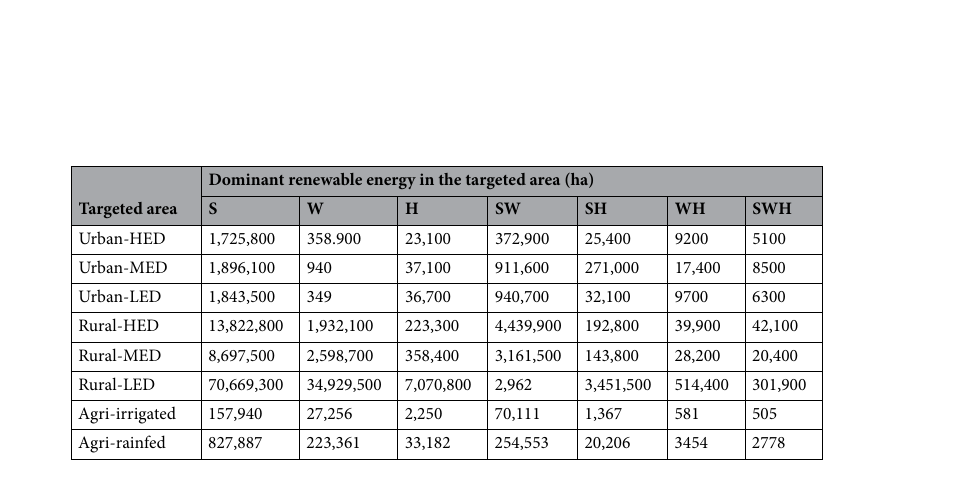
Table 2. Dominant area (ha) for each type of renewable energy in each targeted area. HED high energy demand, MED medium energy demand, LED low energy demand, S solar power, W wind power, H